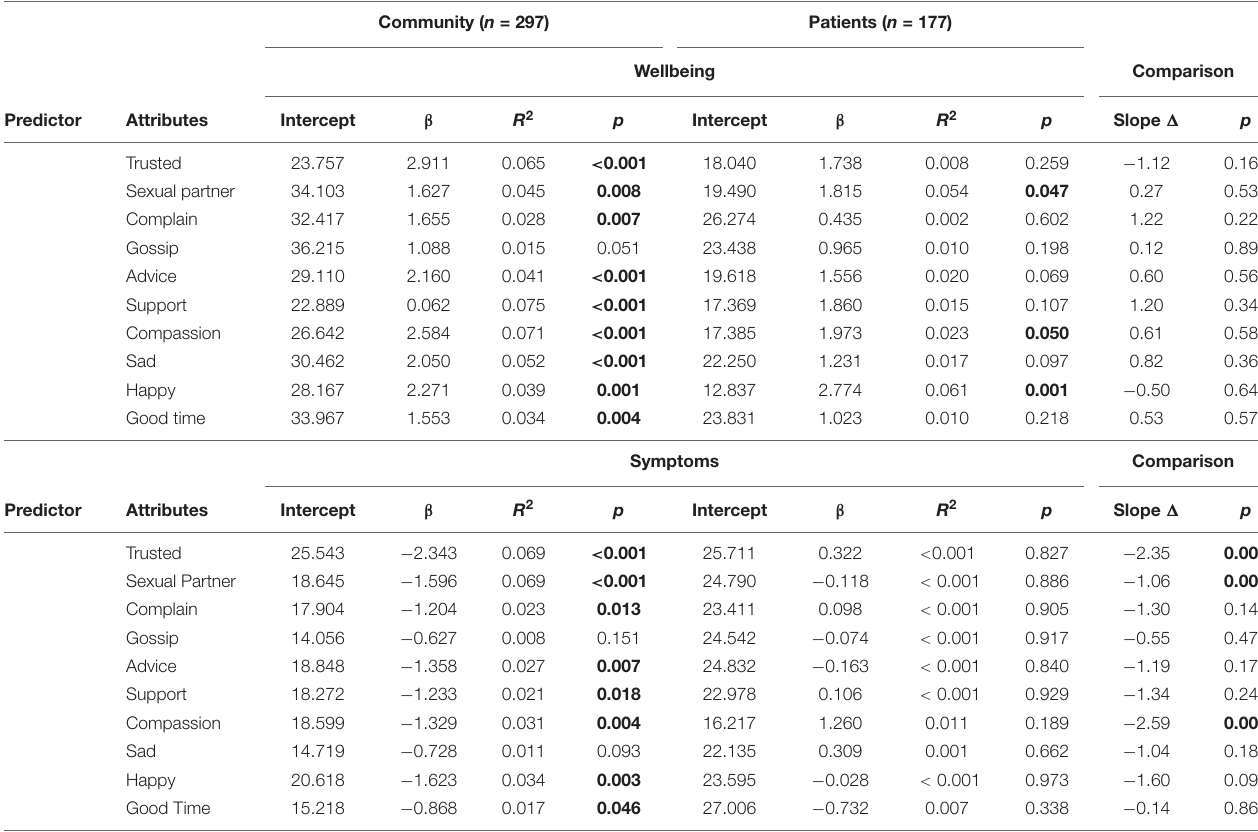
TABLE 5 | Linear regressions for relationship functions with wellbeing or symptoms for the community and the patient sample. Community ( n = 297) Patients ( n = 177)